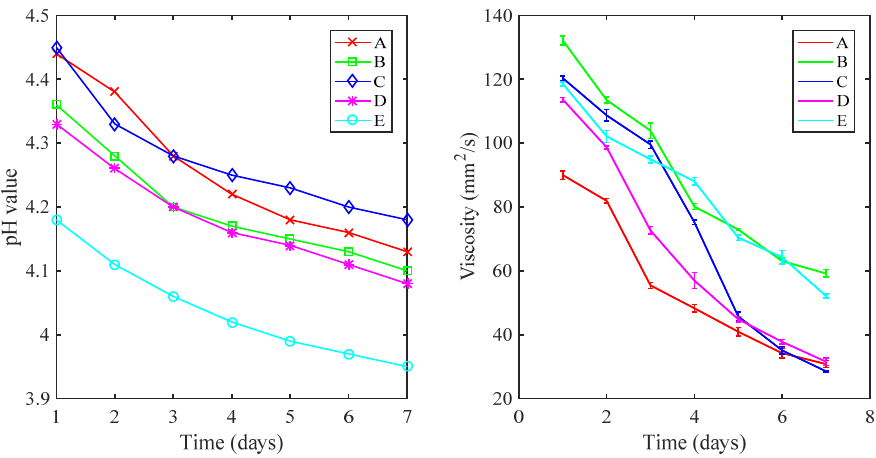
Figure 5. pH value and viscosity of yogurt samples (A, B, C, D, and E) measured over one week.